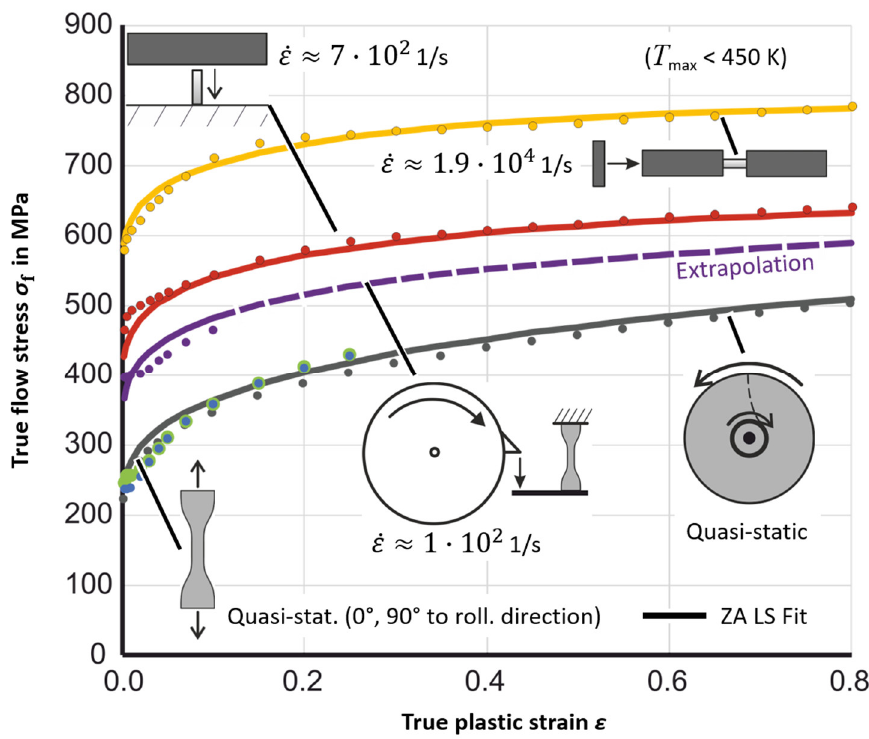
Figure 2. DC01 sheet characterization results at room temperature T RT (1 mm thickness).